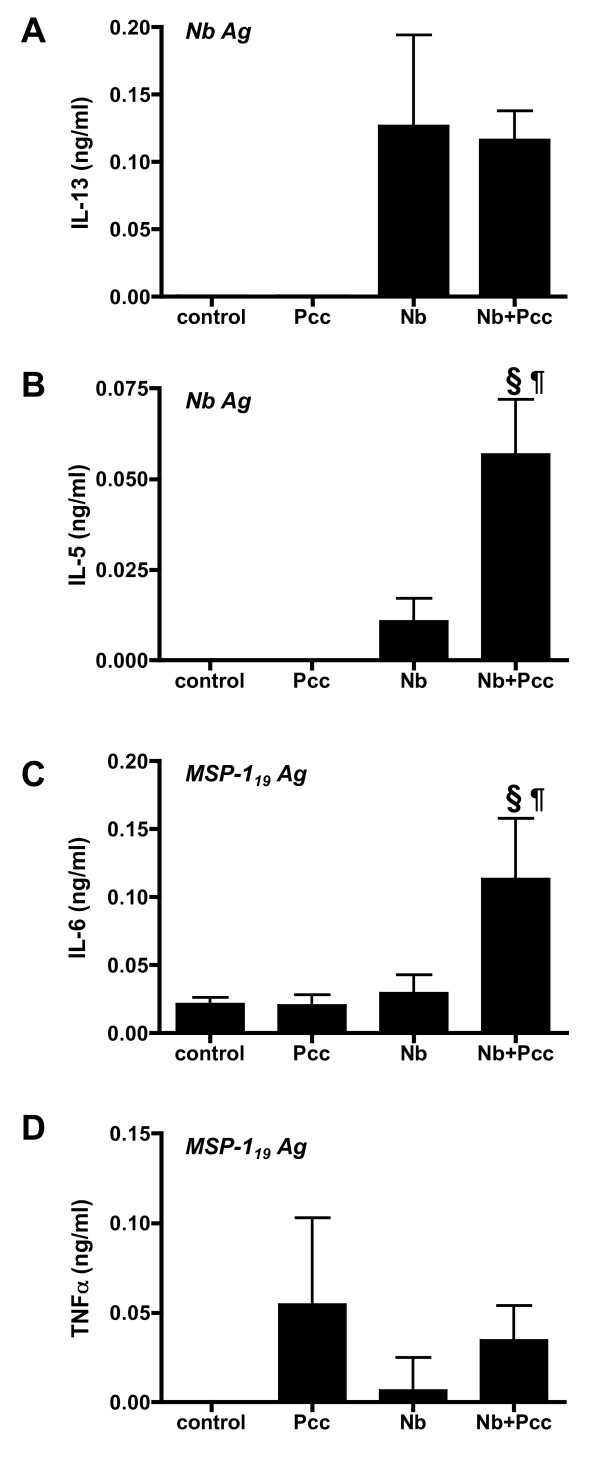
Antigen-specific responses in TLN lymphocyte recall assays. Cytokine concentrations in supernatants of TLN cells that were harvested at day 20 pi and then stimulated with antigen were measured with cytometric bead arrays. Nb Ag, a crude Nb adult lysate, and recombinant Pcc clone AS merozoite surface protein, MSP-119, were used as antigens in vitro. Although all cytokines shown in Figure 8 were measured, only IL-13 in response to Nb Ag (A), IL-5 in response to Nb Ag (B), IL-6 in response to MSP-119 (C), and TNF-α in response to MSP-119 (D) were above levels of spontaneous secretion. These figures thus depict antigen-specific cytokine (in ng/ml above background). Statistically significant differences among groups included increased NbAg-specific IL-13 in all Nb mice (P < 0.0001), increased Nb Ag-specific IL-5 in co-infected (Nb+Pcc) mice compared to both Nb (P = 0.0025) and Pcc mice (P < 0.0001), and increased MSP-119-specific IL-6 in Nb+Pcc compared to both Nb (P = 0.0163) and Pcc mice (P = 0.0112). Bars indicate mean ± SEM for 4-8 mice per group. The symbol ¶ indicates significance of the difference between co-infected and Nb mice, while § indicates significance of the difference between co-infected and Pcc mice (P values included above and in Results text).